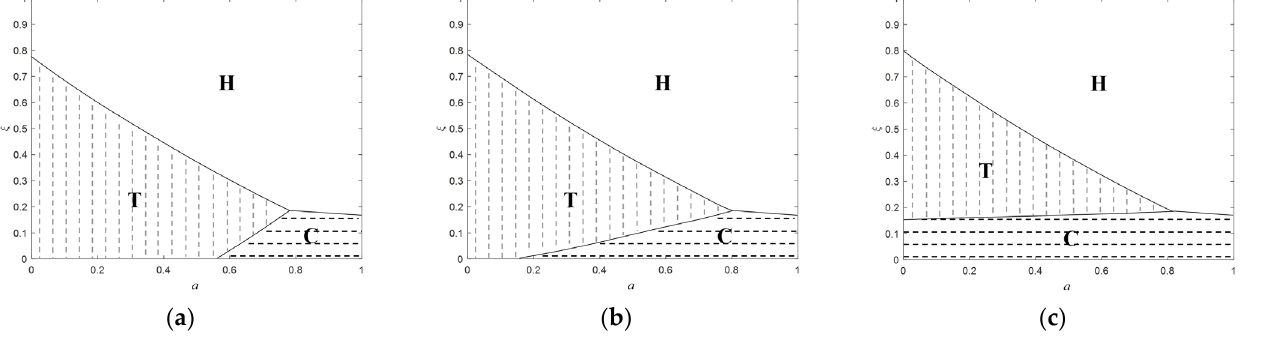
Figure 2. Return policy selection of brand under low commission rate . ( a ) ( c ) δ =